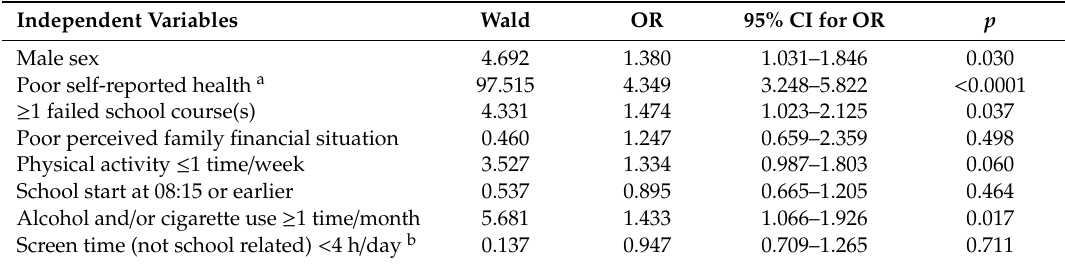
Table 2. Multiple logistic regression analysis of factors associated with insomnia (MISS ≥ 6) among adolescents aged 15–17 years (n = 1477).